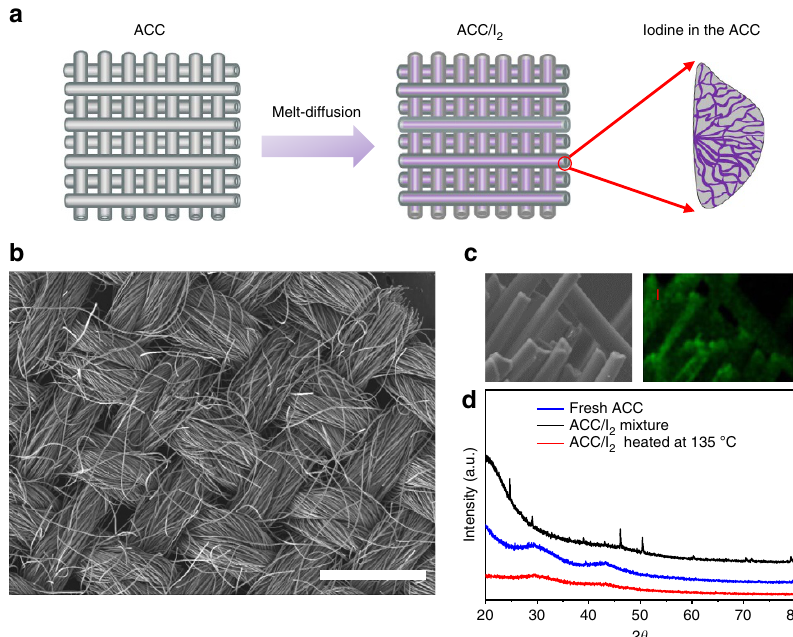
Figure 2 | Material characterization of the active carbon cloth/iodine cathode. ( a ) Procedure for preparing the ACC/I 2 electrode. ( b ) Scanning electron microscopy images of the ACC/I 2 cathode, scale bar: 1mm. ( c ) Energy-dispersive spectroscopy mapping of I in the ACC/I 2 cathode. ( d ) X-ray diffraction pattern of the ACC/I 2